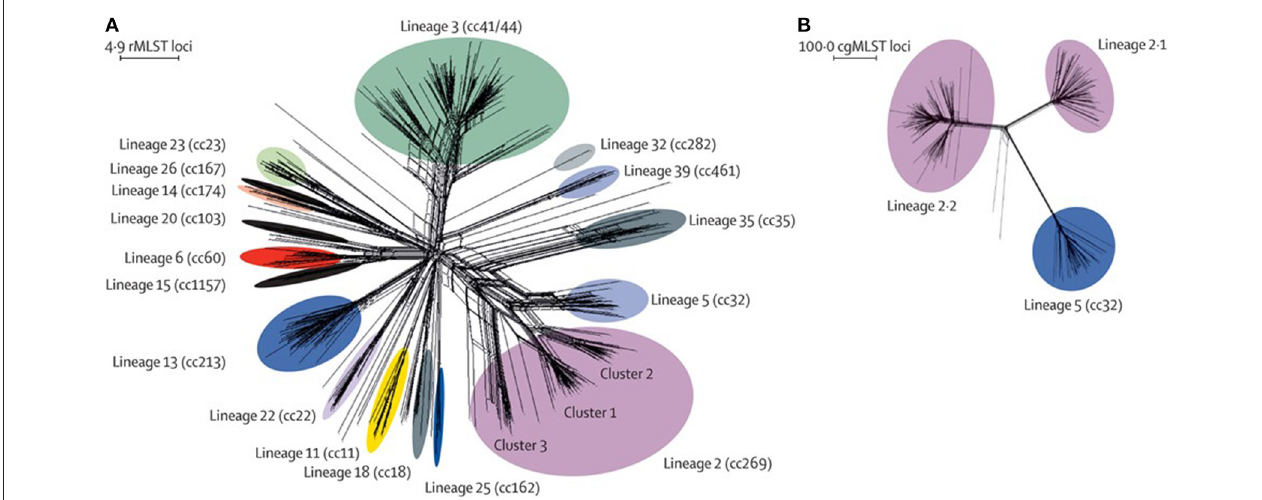
FIGURE 4 | Genetic diversity of disease-associated meningococcal isolates in the Meningitis Research Foundation Meningococcus Genome Library for England and Wales (A) Neighbor-Net graph showing the relationships of all 498 rMLST profiles (ribosomal sequence types) within the 899 isolates available for epidemiological years 2010–2011 and 2011–2012. (B) Relationships among isolates belonging to lineage 2 (cc269; n = 171) and lineage 5 (cc32) isolates ( n = 42) assessed with 1605 cgMLST loci. This analysis illustrates the improved resolution achieved with cgMLST for the substructures within and between lineages, compared with rMLST. rMLST = ribosomal multilocus sequence typing. cc = clonal complex. cgMLST = core-genome multilocus sequence typing. Reproduced without modification from Hill et al. ( 73) Under CC